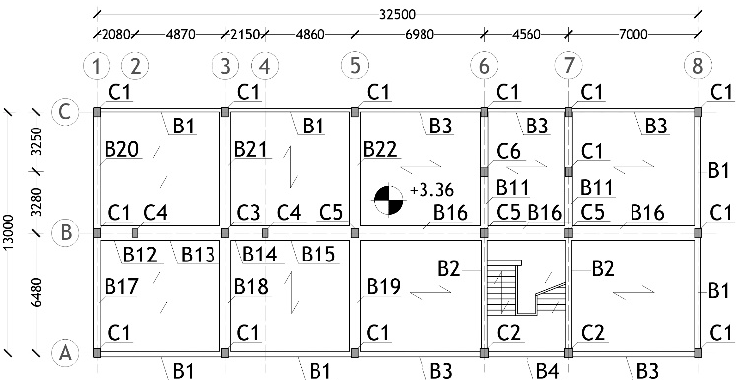
Figure 2. First floor structural plan.